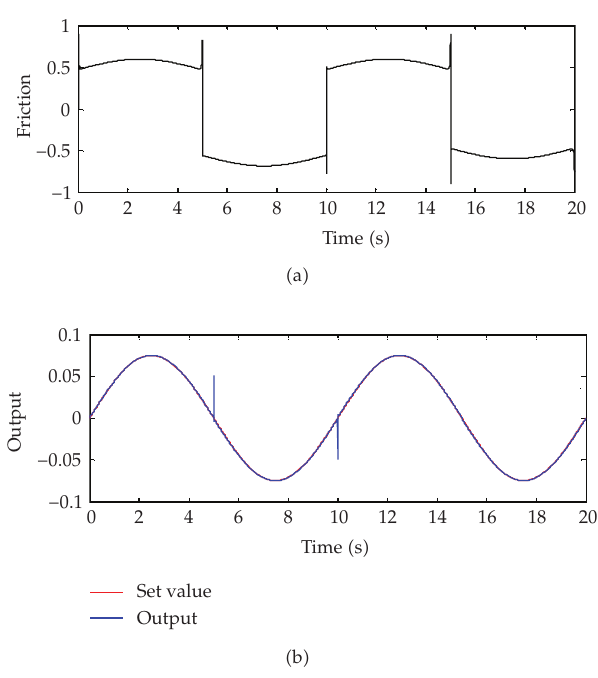
Figure 10: Reference signal is sinusoidal signal of 0.1Hz.